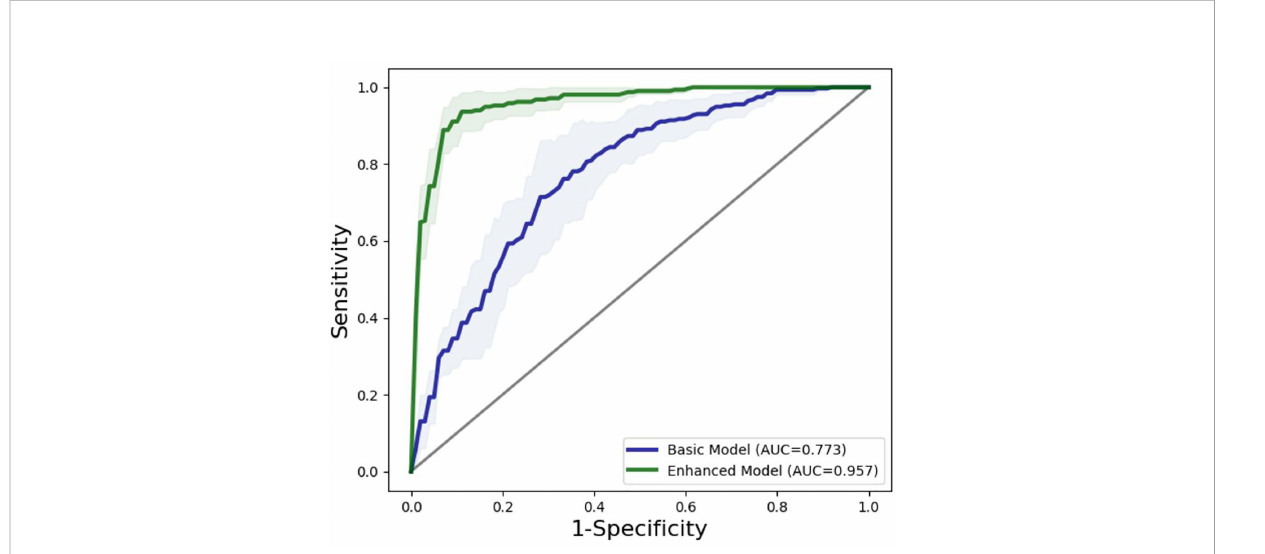
FIGURE 3 ROC curves of basic model and enhanced model. The lines re fl ect the average performances of the models, and the light-colored area re fl ects the fl uctuation of the models represented by the corresponding standard deviations.